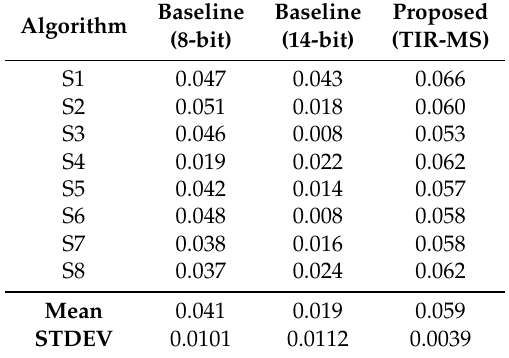
Table 3. Comparison of tracking stability: average